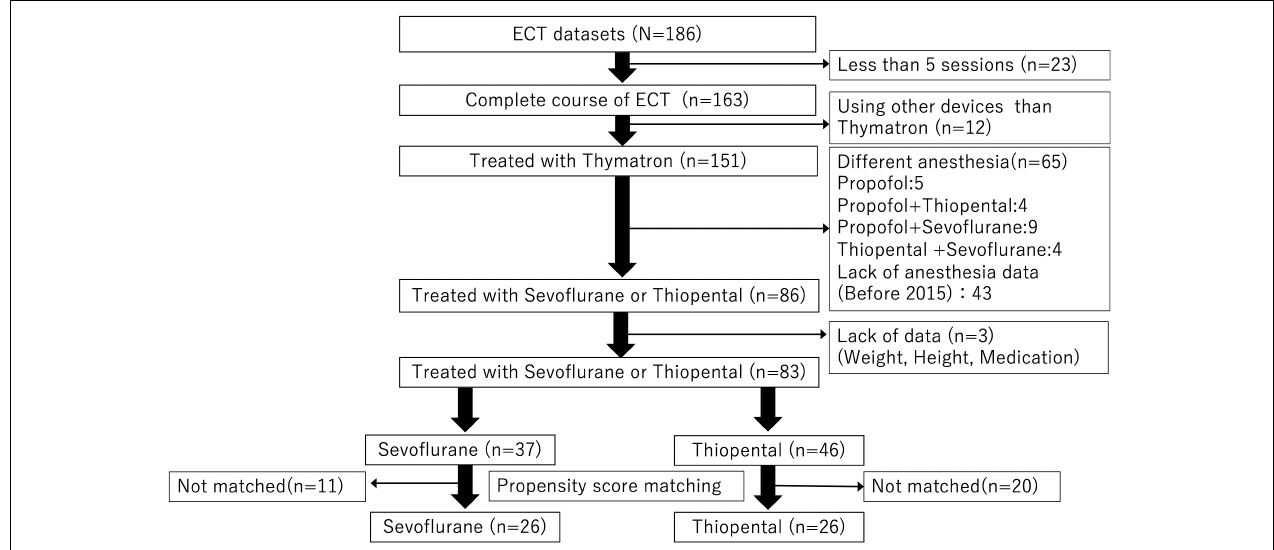
FIGURE 1 | Data extraction flow. Among 186 patients with depression, 83 patients exposed to general anesthesia with sevoflurane or thiopental were included in the analysis. A total of 52 patients (26 patients per anesthetic group) were compared using propensity score matching.